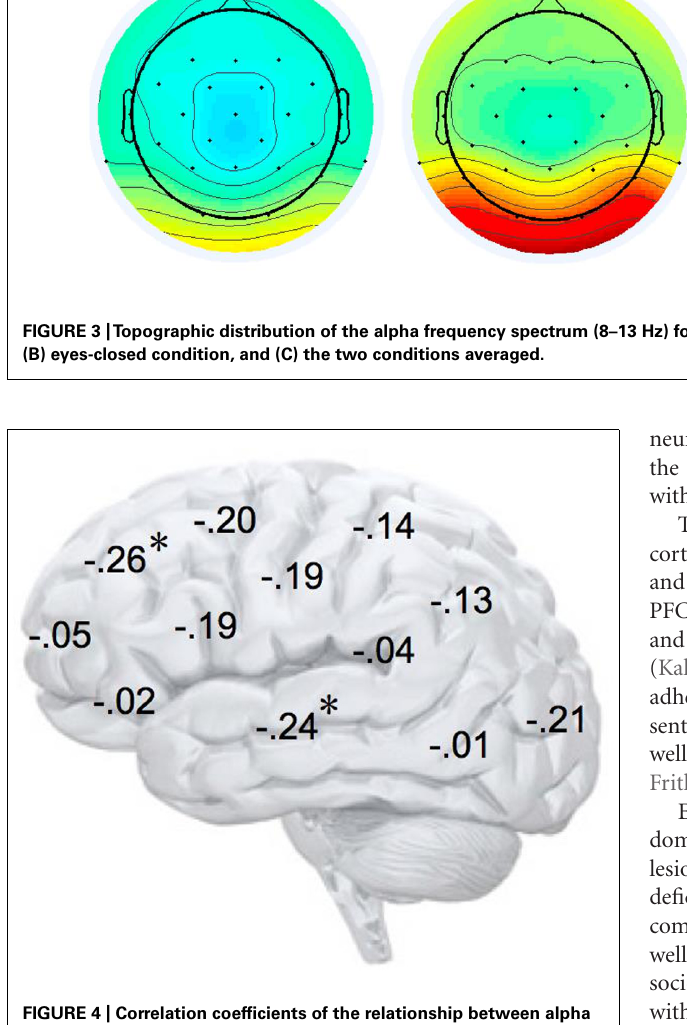
FIGURE 4 | Correlation coefficients of the relationship between alpha asymmetry scores at each electrode site and the implicit affiliation motive. N = 72; ∗ p < 0.05; negative coefficients indicate lower relative right-lateralized activity being associated with low levels of implicit